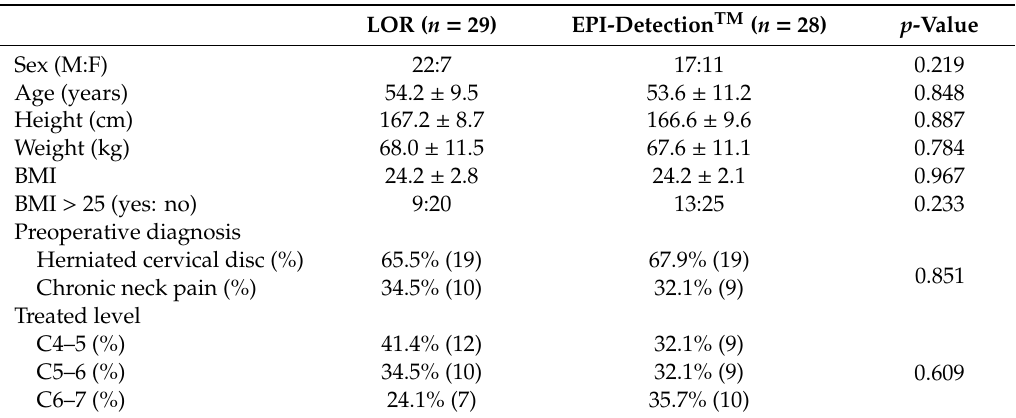
Table 1. All patients were discharged within 24 h of undergoing the assigned procedure. Table 1. Summary of patient demographic and baseline clinical